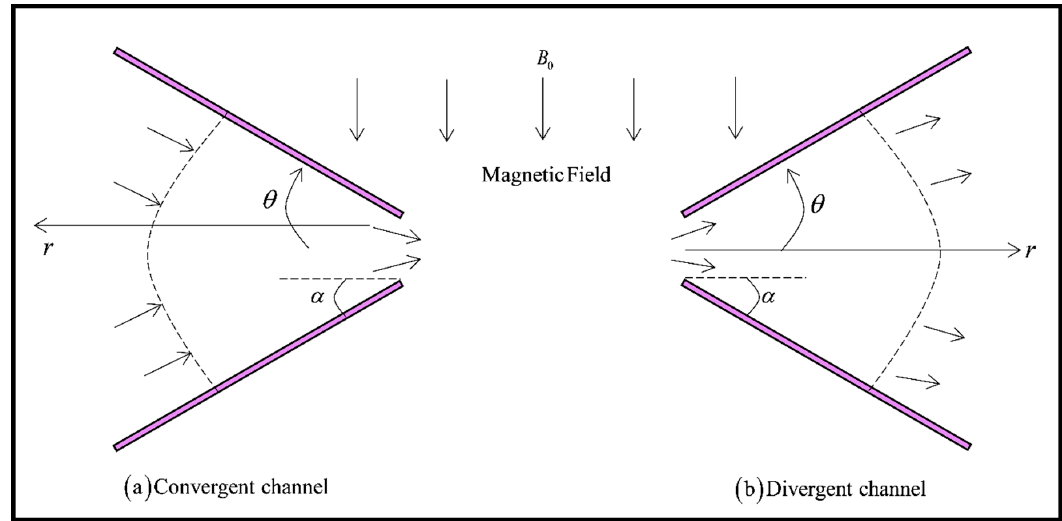
α (Adapted from Motsa,